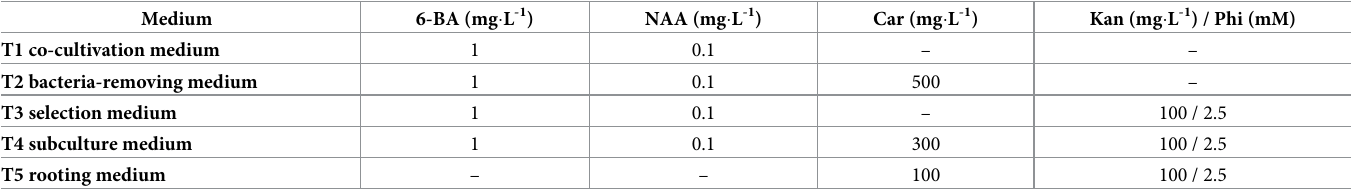
Table 2. MS-based culture medium used in different stages of Agrobacterium-mediated tobacco transformation under selection of Kan or Phi.